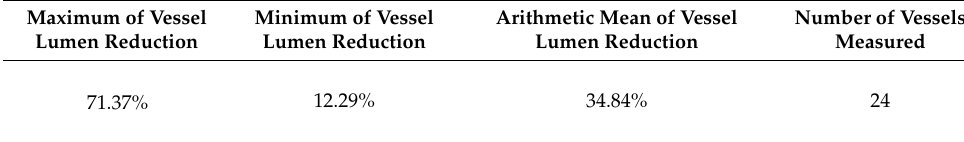
Table 2. Overview of Vessel Lumen